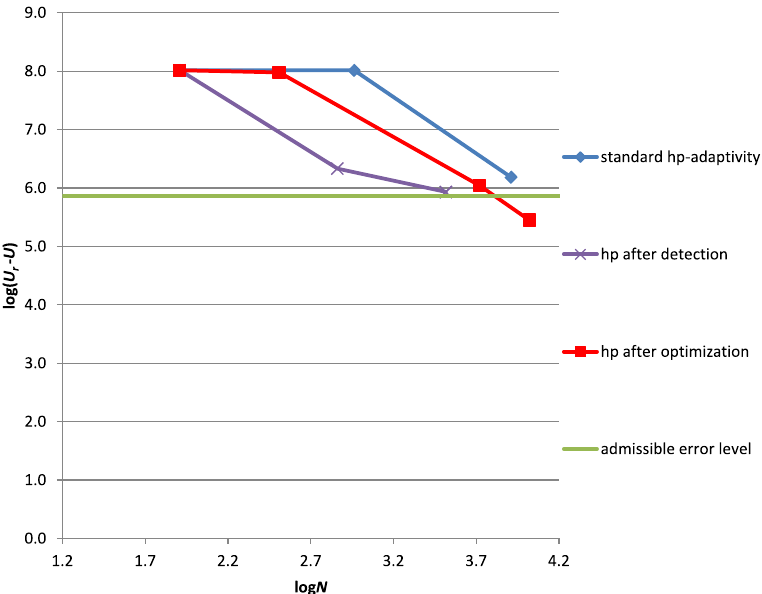
Figure 26. A quarter of a bending-dominated shell—convergence for three adaptation